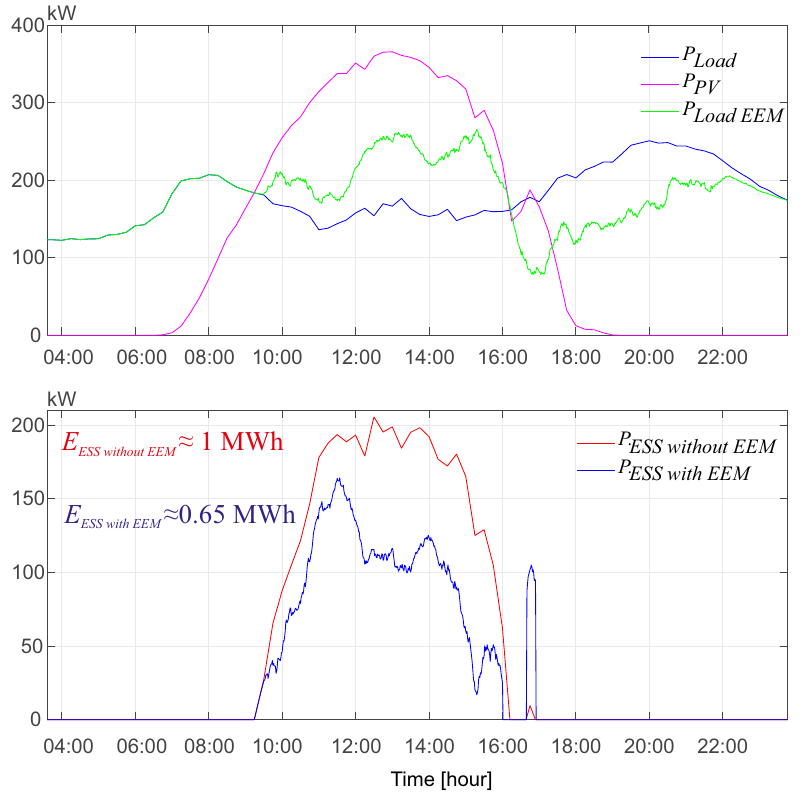
Figure 16. Experimental results: ( top ) load profile comparison with and without EEM algorithm; ( bottom ) comparison of unused energy from PV